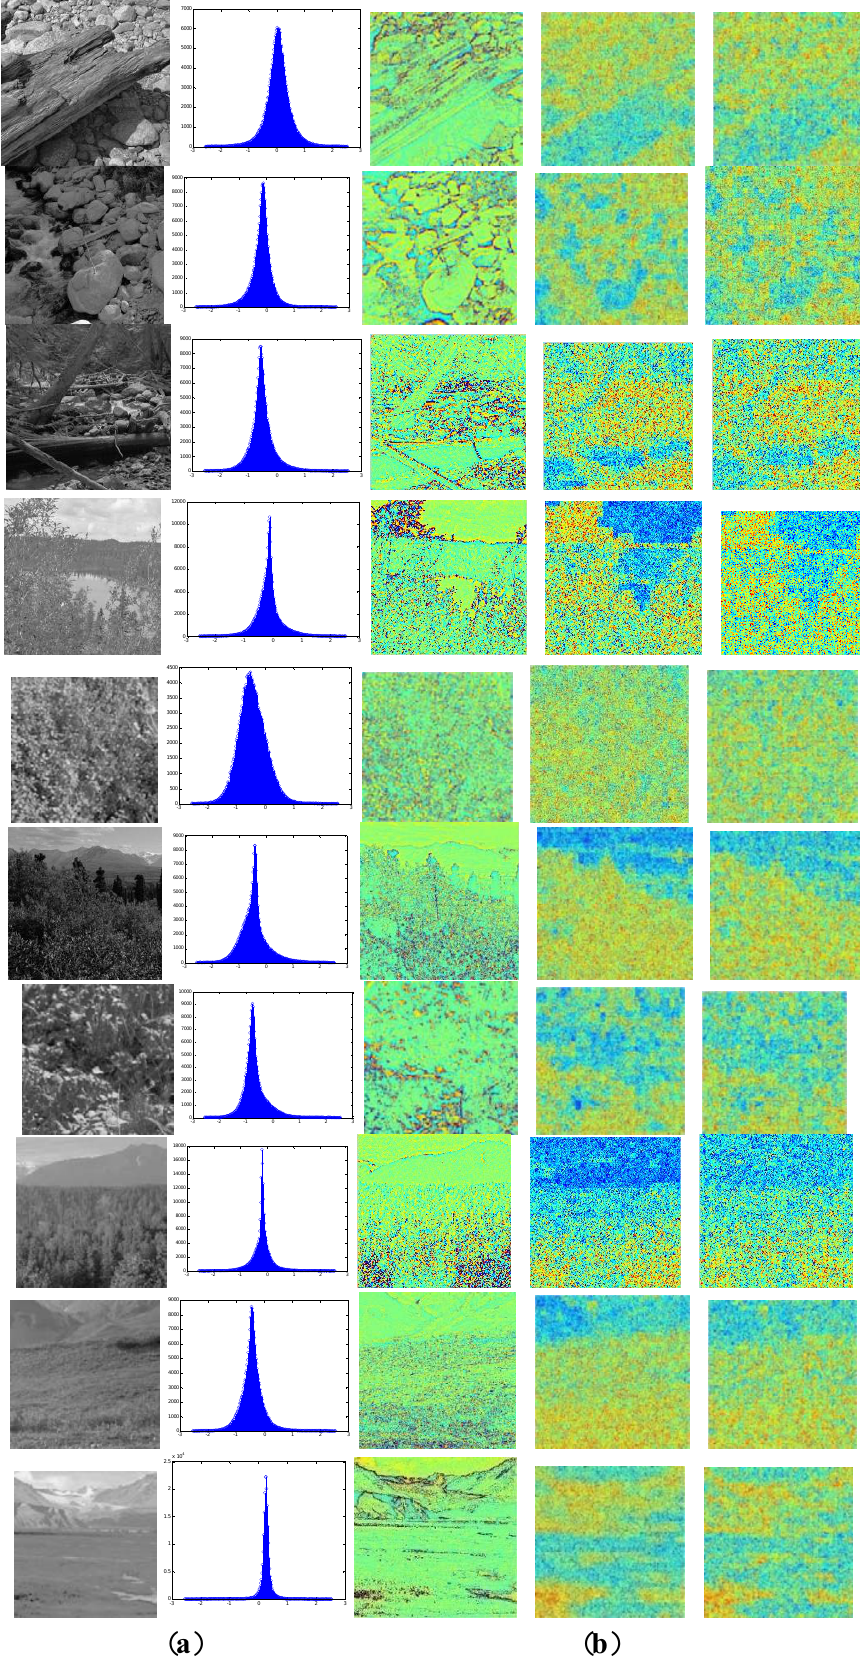
Figure 8. The activation maps for the natural images in each layer. ( a ) The original image and the distribution. ( b ) ICA responses in the 1st, 2nd, 3rd